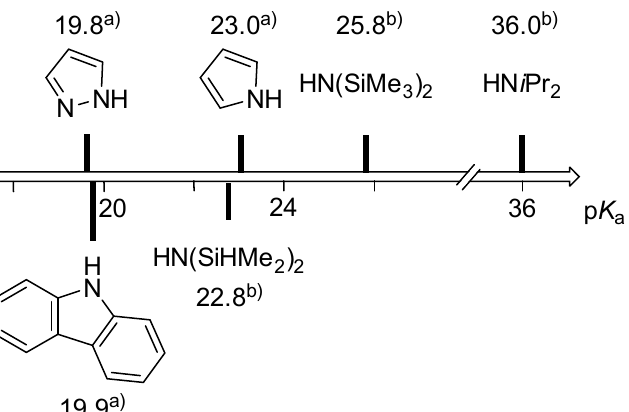
Figure 1. p K a values of the different N -proligands [40,63,64]. a) Determined in DMSO, b) determined in THF.